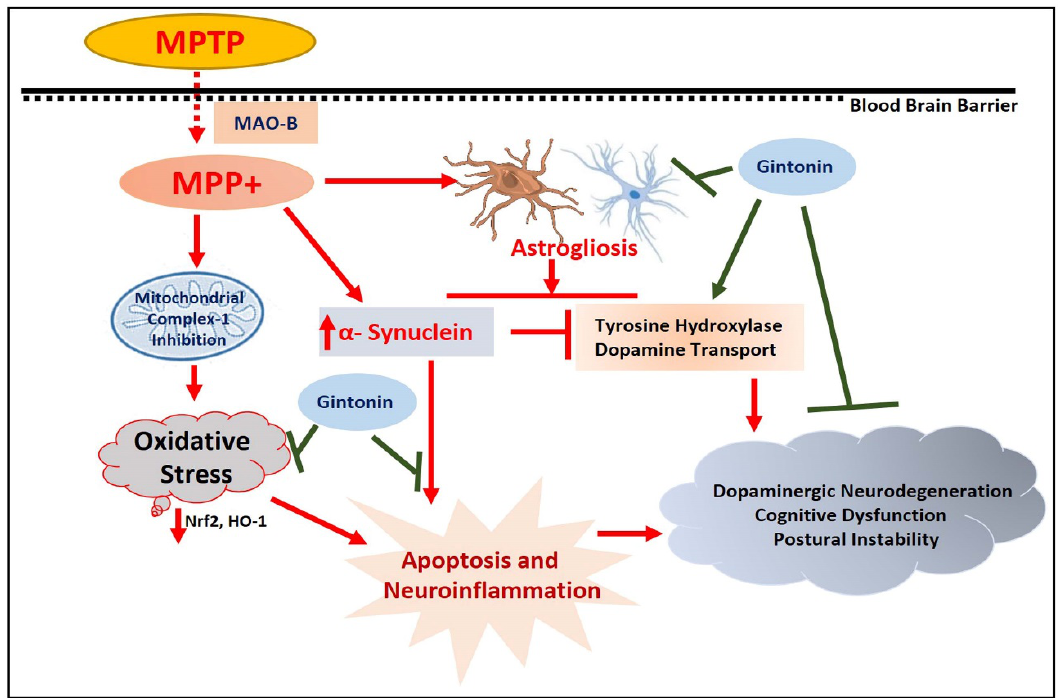
Figure 4. Effects of gintonin against Parkinson's disease. A simple illustration, showing the rescuing effects of gintonin against MPTP-induced dopaminergic neurodegeneration and motor dysfunctions, covering the antioxidant, anti-inflammatory, and anti-apoptotic effects of gintonin. MPTP: 1-methyl-4-phenyl- 1,2,3,6-tetrahydropyridine), Nrf2: nuclear factor erythroid 2-related factor 2, HO-1: Heme oxygenase-1, BAX: (BCL2 Associated X, Apoptosis Regulator, Bcl-2: B-cell lymphoma 2, MPP+: 1-methyl-4-phenylpyridinium.